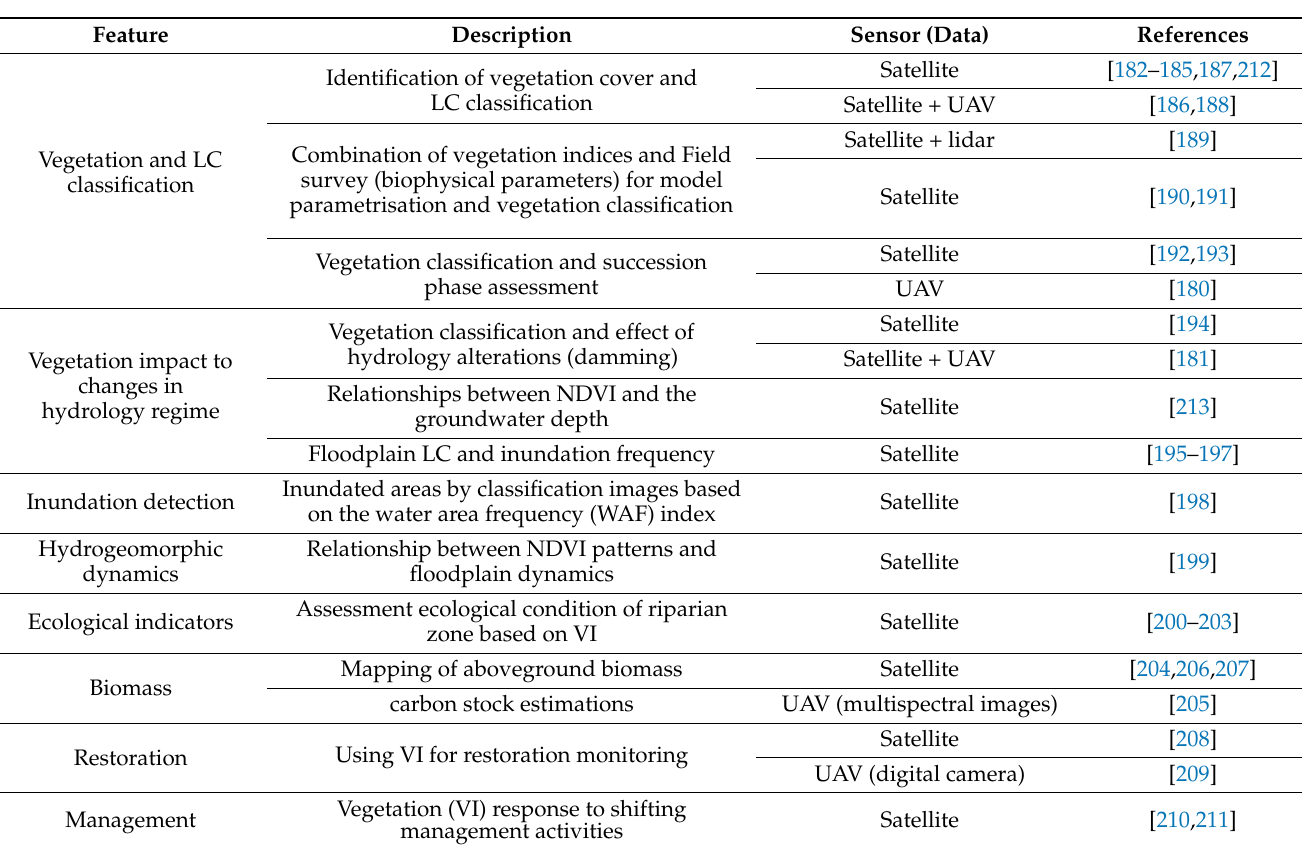
Table 4. Vegetation properties and water area detection based on vegetation and water indices calcu- lated from multispectral sensors. Studies are sorted based on a short description of the methodologies and sensors